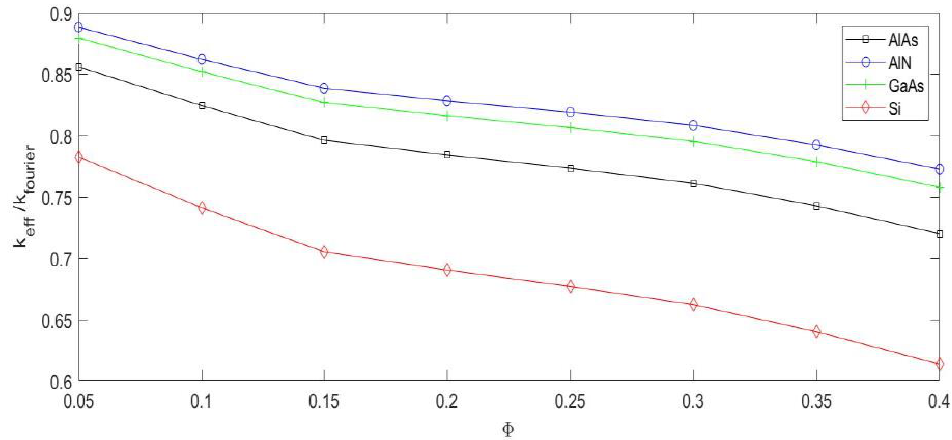
Figure 12. The effective thermal conductivity in rectangle pores with different materials, at 300 k. In order to evaluate the influence of the location of pore shapes, we calculate the effective thermal conductivity in material made of AlAs for two kinds of rectangles. For one kind of rectangle, we set the parameter as P l = 2 P d which means the aspect ratio of the rectangle is 2 and for the other kind of the rectangle, we set the parameter as P d = 2 P l which means the aspect ratio of the rectangle is 0.5, as shown in Figure 13. From this figure, it can be clearly seen that the effective thermal conductivity of the rectangle with P l = 2 P d structure is always higher than the rectangle with P d = 2 P l structure and the gap between the two line widens with the growth of the porosity. From this result, we can see that the locations of the pores block the heat flux through the materials, changing the direction of the heat flux and affecting the effective thermal